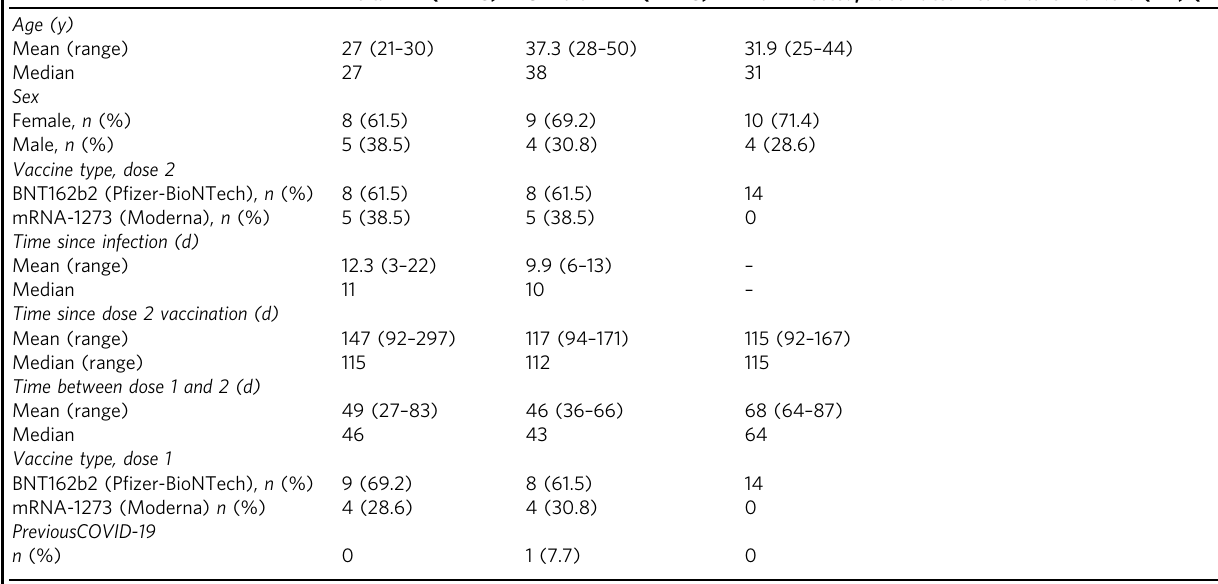
Table 1 Overview of BTI.